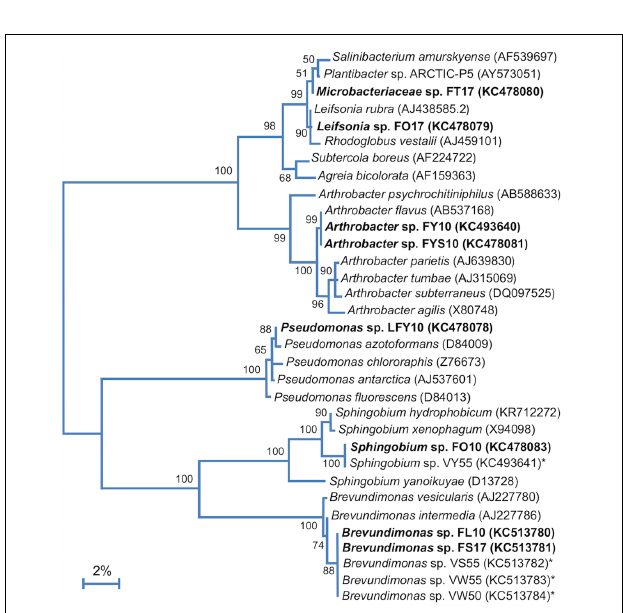
FIGURE 3 | 16S rRNA phylogenetic analysis of the Lake Fryxell bacterial isolates (bold). 16S rRNA gene sequences from Lake Fryxell isolates and type strains of related species were aligned using Muscle ( n = 1311 in final data set). The tree was constructed in Mega7 (v. 7.0.26) using the Maximum Likelihood method and the Jukes-Cantor model. 500 bootstrap replicates were obtained to determine validity (values shown at branch points indicate the percentage of replicates in which the node was observed). Asterisks ( ∗ ) indicate isolates from nearby Lake Vanda described in our previous work (Vander Schaaf et al., 2015). GenBank accession numbers are shown in parentheses. The scale bar indicates a distance equivalent to 2 nucleotide changes per 100